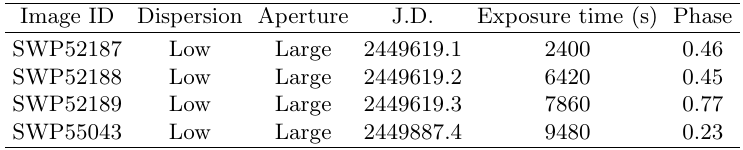
Table 1. Journal of IUE observations of HU Aqr.